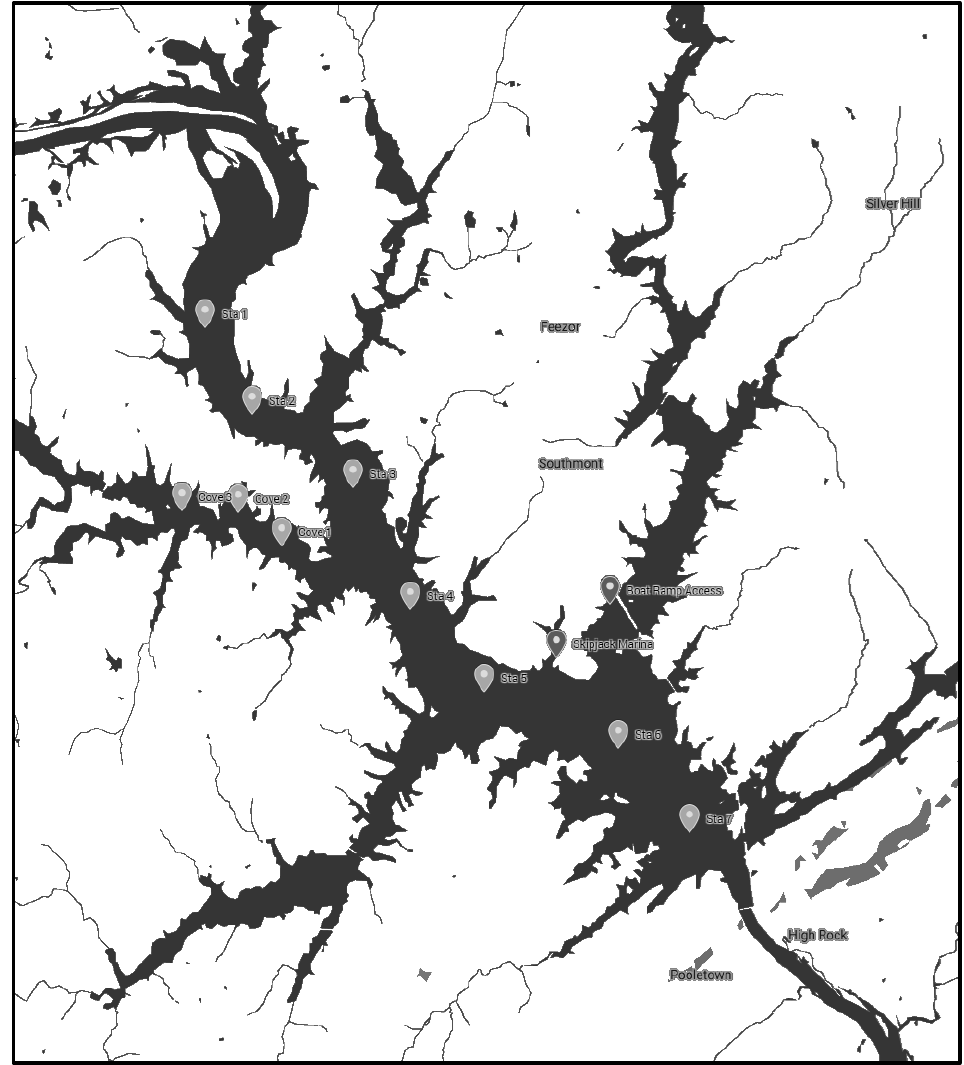
Figure 1. High Rock Lake, North Carolina. Sampling points of interest.